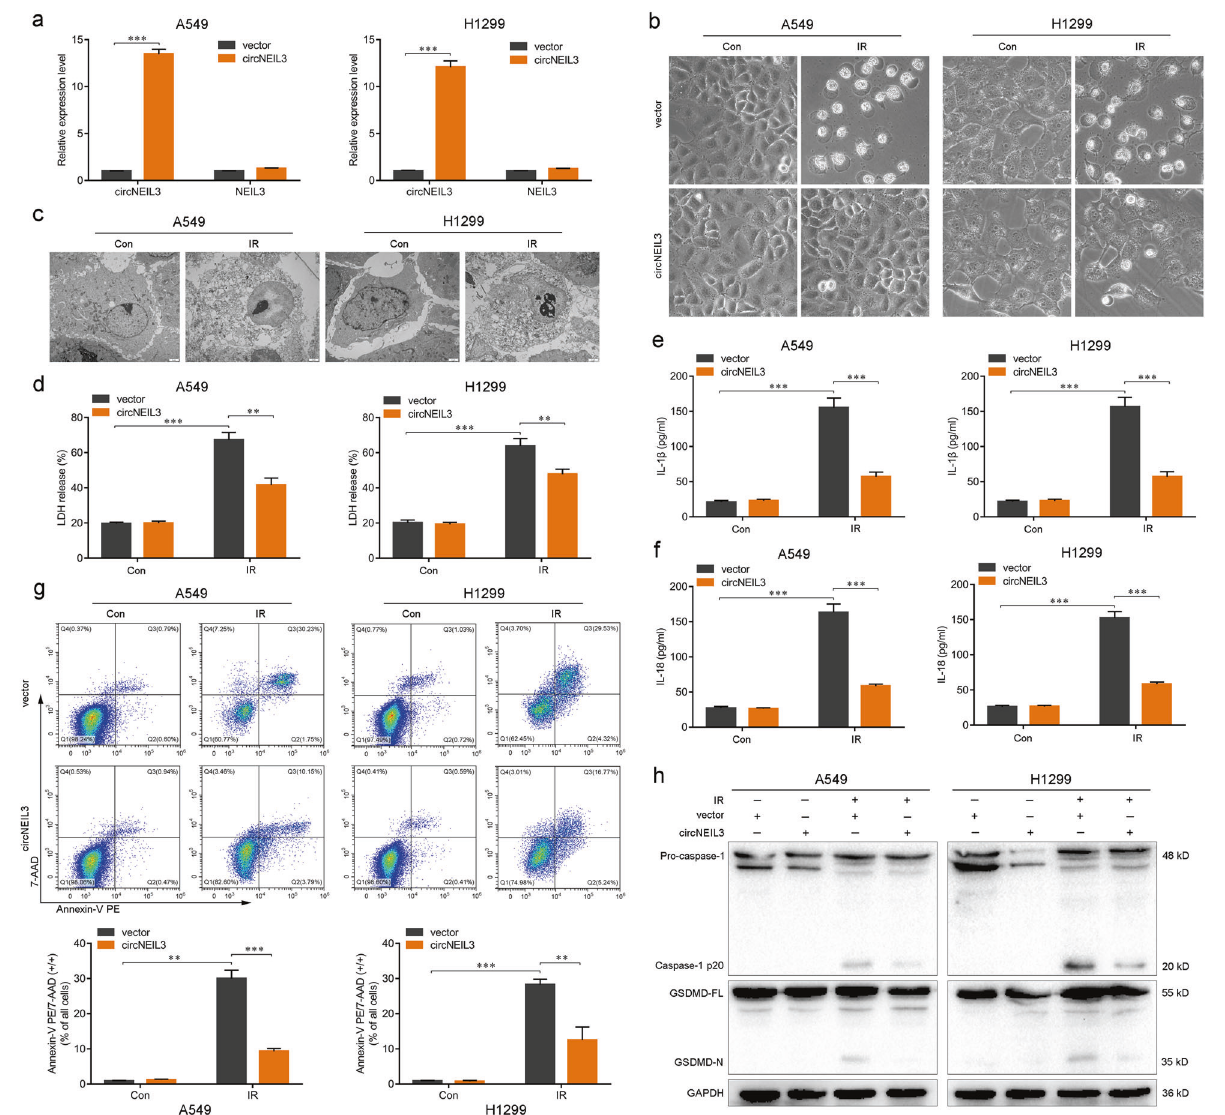
7-AAD double-positive cells in LUAD cells as detected using fl ow cytometry. h Analysis of pyroptosis markers (caspase-1, GSDMD-N) by western blotting in the indicated groups. ** P < 0.01, *** P < 0.001, two-tailed Student ’ s t -test. Con control, IR